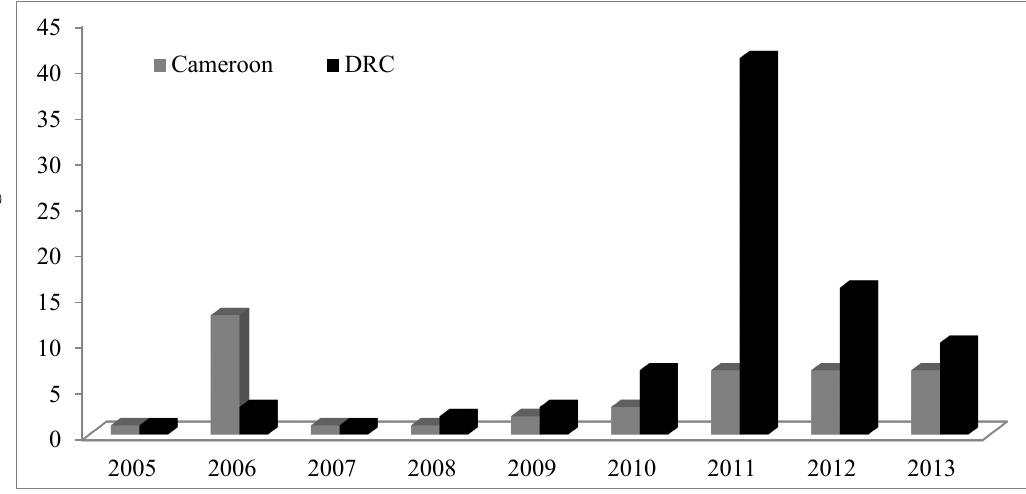
Figure 2. Participation of delegates during SBSTA and SBI REDD+ sessions.